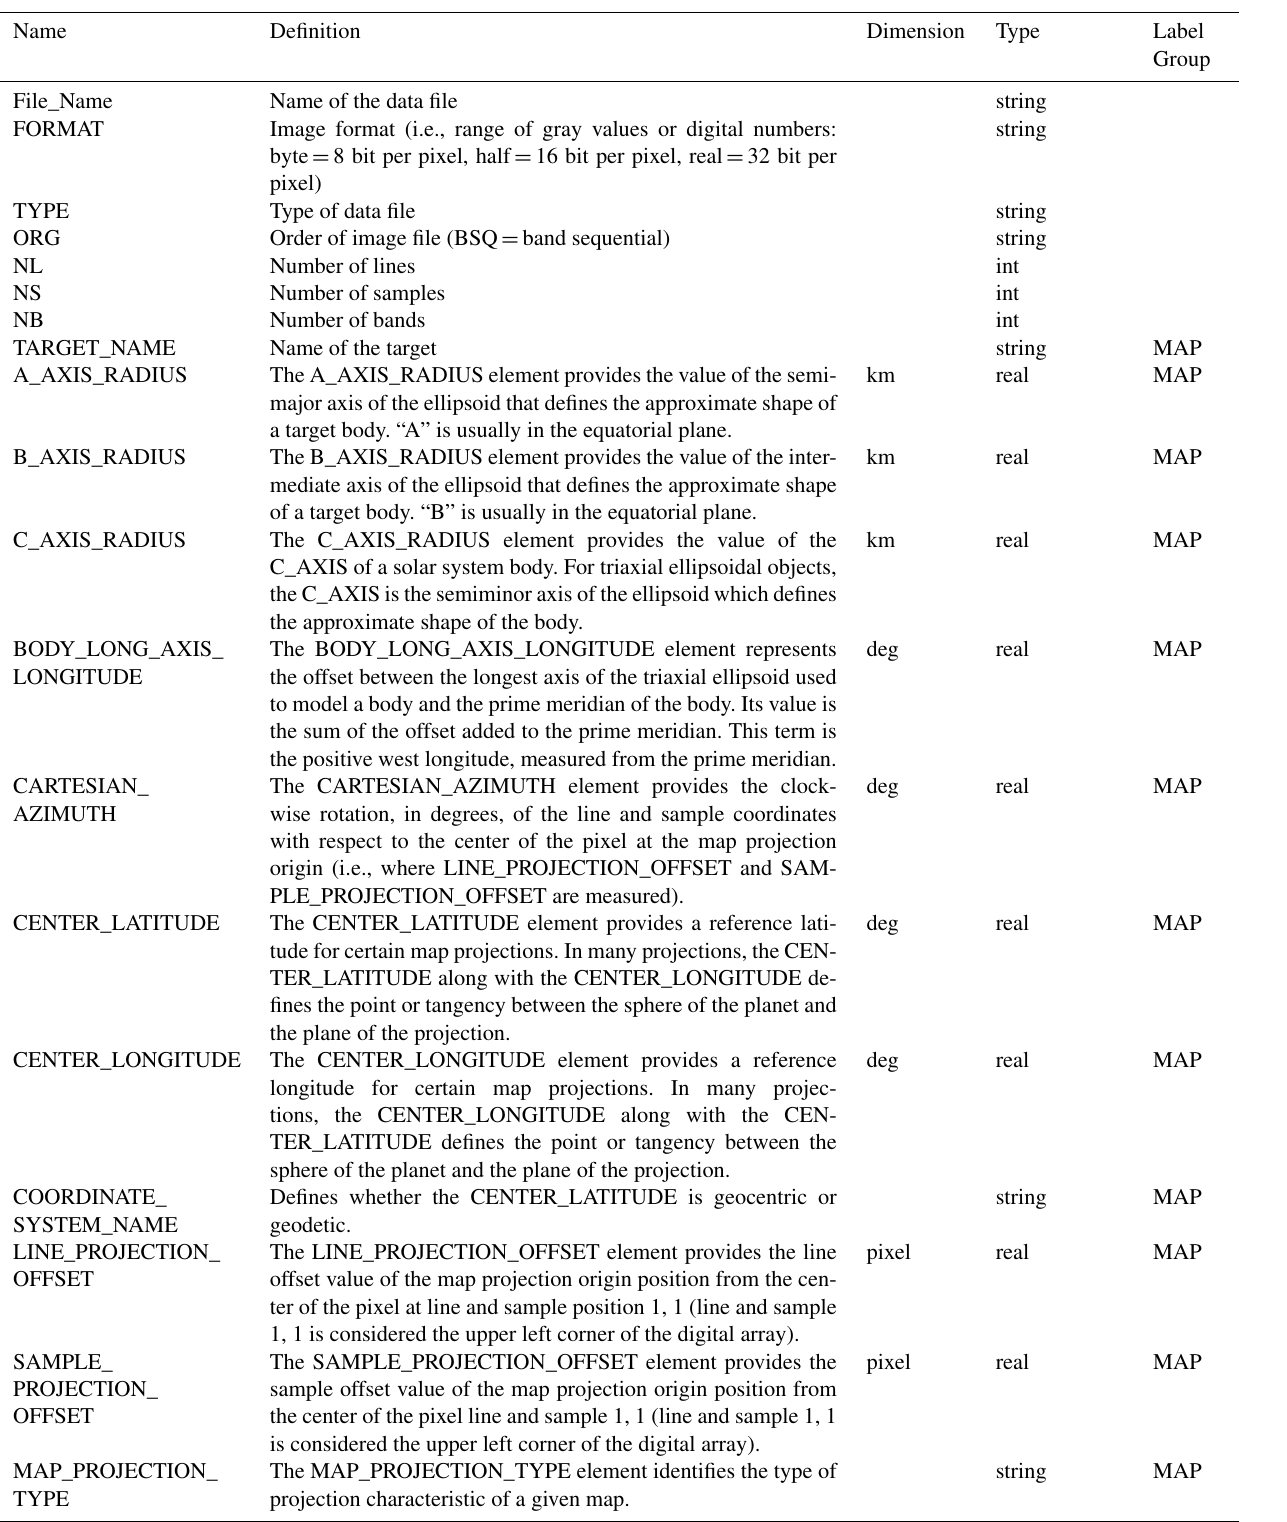
Table B2. Description of metadata (keyword-value pairs) contained in the HRSC-AX image